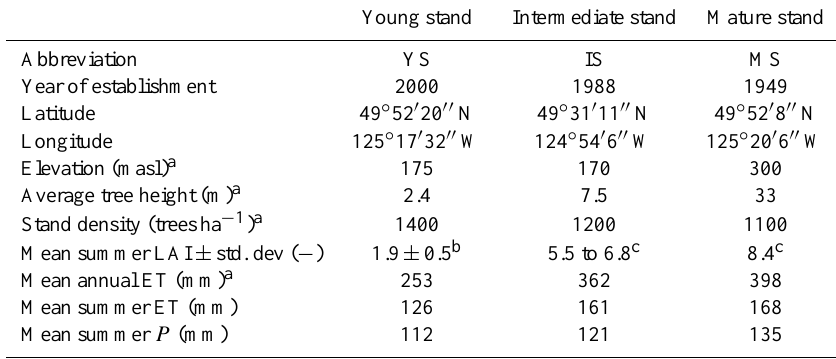
Table 2. Characteristics of the successional forest chronosequence experimental sites in Campbell River,